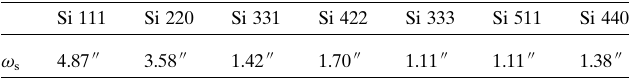
Table 2 Example of the calculated ! s for (cid:5) -polarized X-rays with a wavelength of 0.112